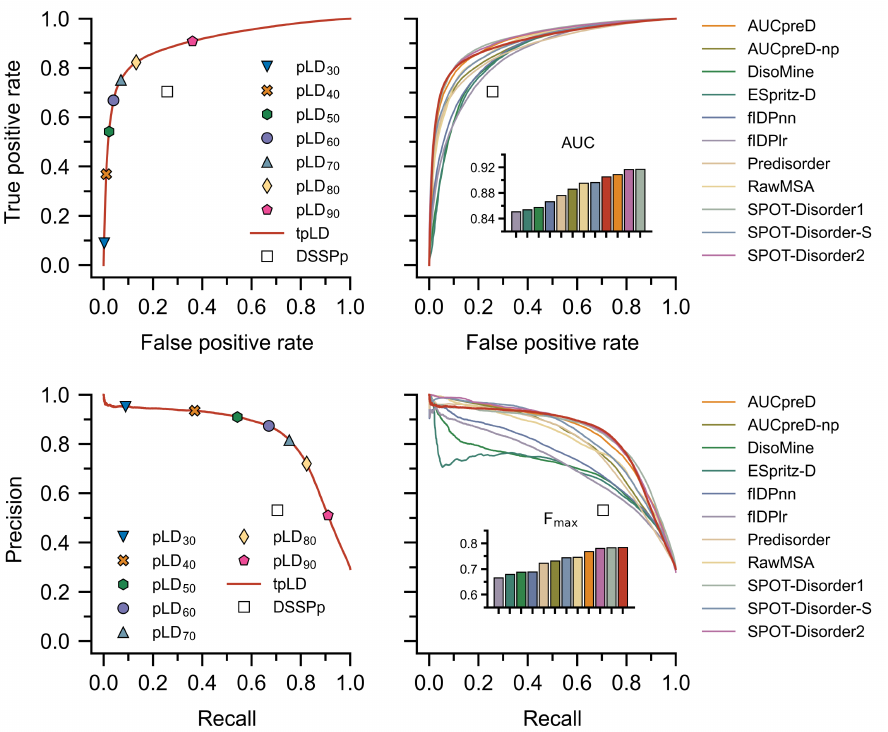
Figure 1. Receiver operating characteristic (ROC) curves ( top ) and precision–recall ( bottom ) are depicted for various predictors calculated per residue on the DisProt-PDB dataset. Note that a ROC curve captures the probability of true and false positives at all thresholds, where an ideal predictor will have an area under the curve (AUC) equal to 1. Further note that a precision–recall curve captures the trade-off between precision and recall; again, in the ideal case the harmonic mean of the precision and recall (F max ) will be equal to 1; bar colors correspond to the legend, red denotes tpLD. In all cases the tpLD (Equation (1)) and various discrete pLD n predictors are indicated alongside DSSPp. The tpLD predictor resulted in one of the highest AUC values and the highest F max on the DisProt-PDB dataset. pLDDT is abbreviated as pLD for plotting purposes.